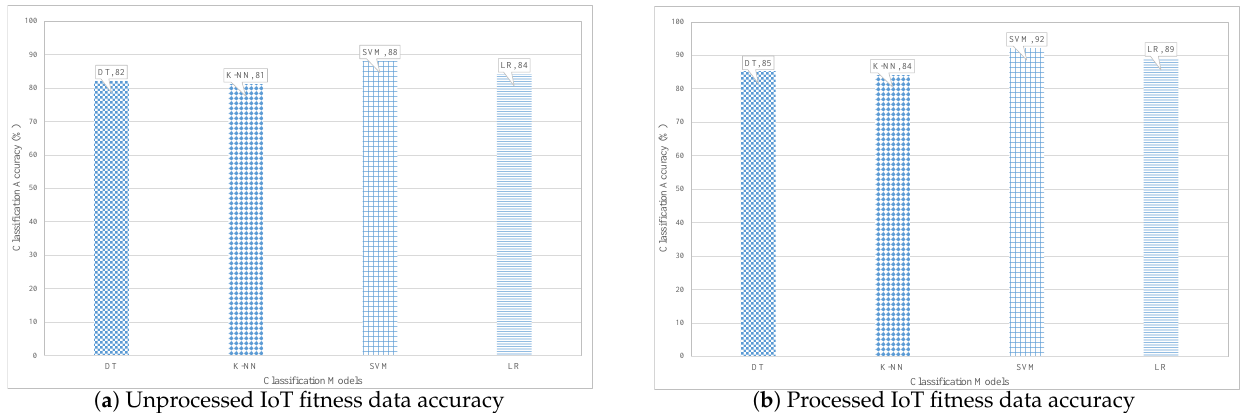
Figure 9. Performance results of different learning methods for IoT fitness dataset.